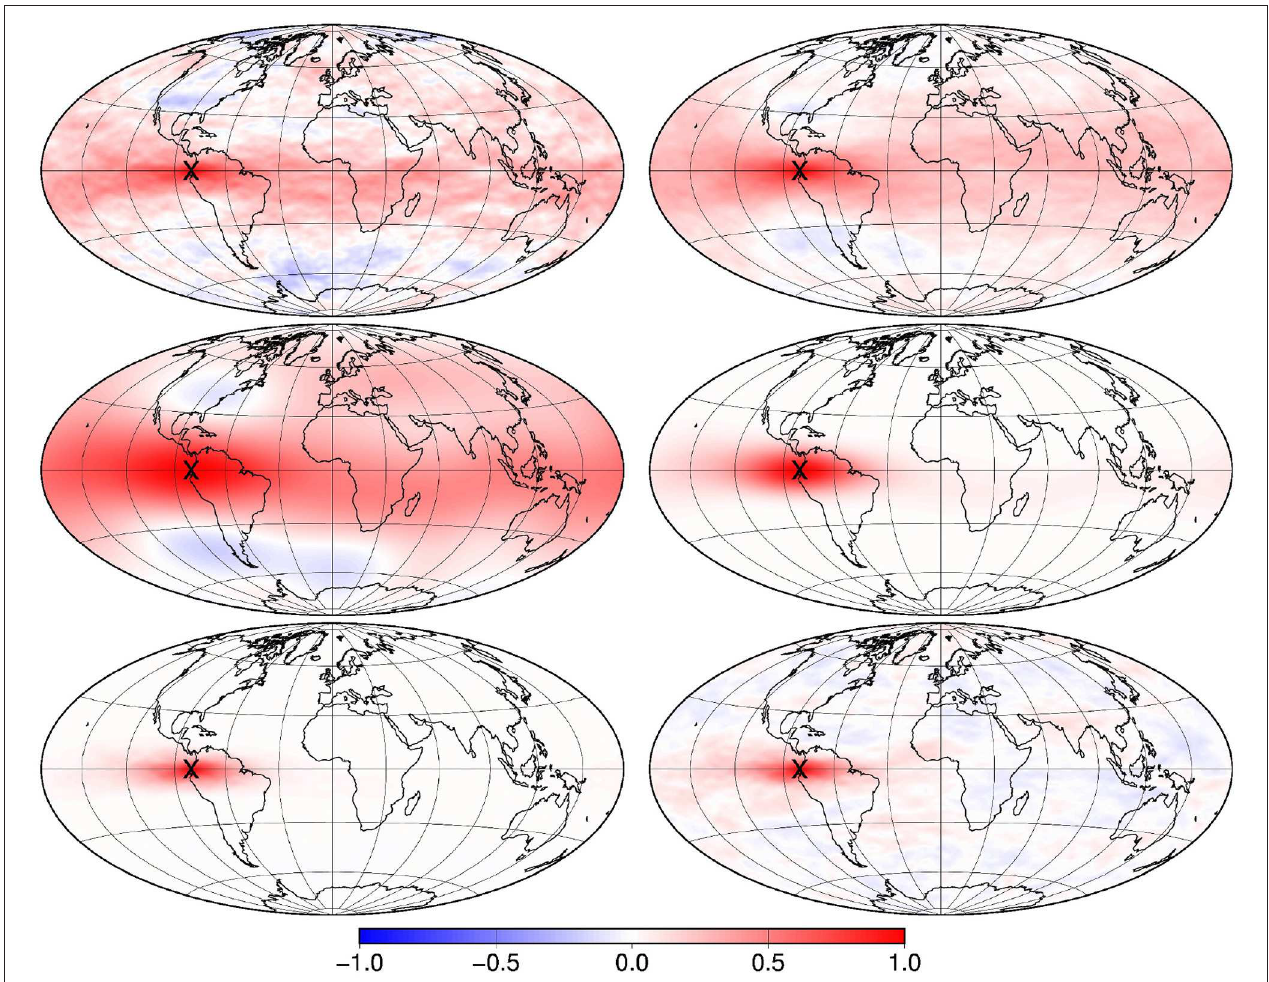
FIGURE 6 | Correlation maps with respect to a reference location on the equator in the Eastern Pacific: 100-member prior correlation (top left) , 500-member prior correlation (top right) , 100-member correlation for the large-scale patterns (middle left) , localizing correlation (middle right) , localized correlation (bottom left) and correlation associated to a 500-member augmented ensemble (bottom right)